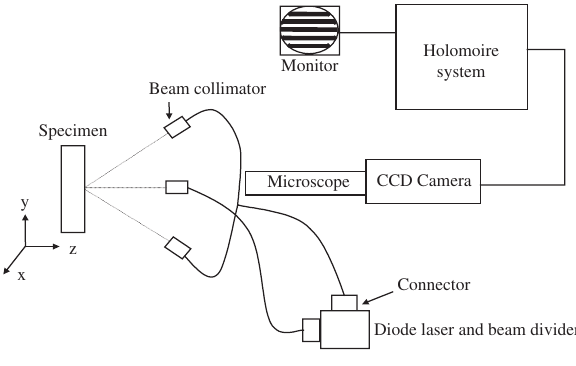
Figure 1 Optical set-up.